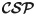
Results of the annotation of a Porifera in the CS primer-experiment CSP.The expert annotation is in red while the CS annotations are in yellow and the protocol-corrected expert annotation is in blue. The radii selected by the CS are more than 10 times the expert annotation radius.